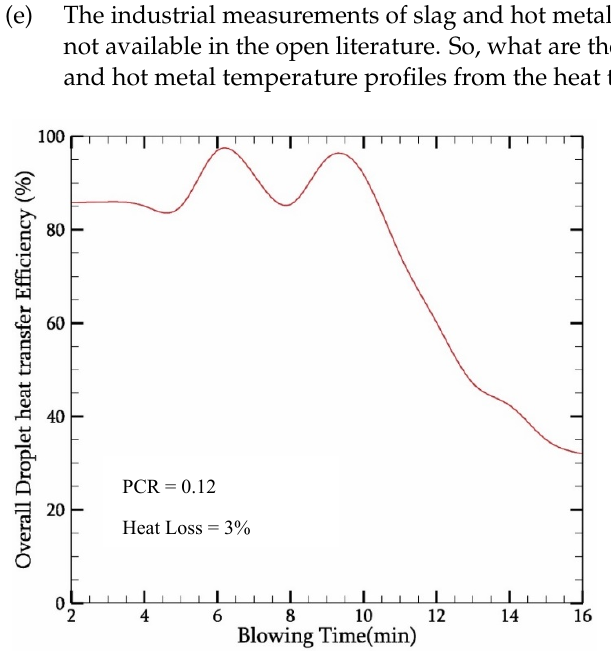
Figure 11. Overall droplet heat transfer efficiency throughout the blowing period for a heat loss of 3%.